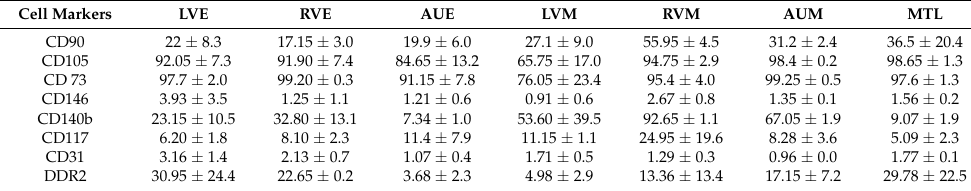
Table 1. Explant